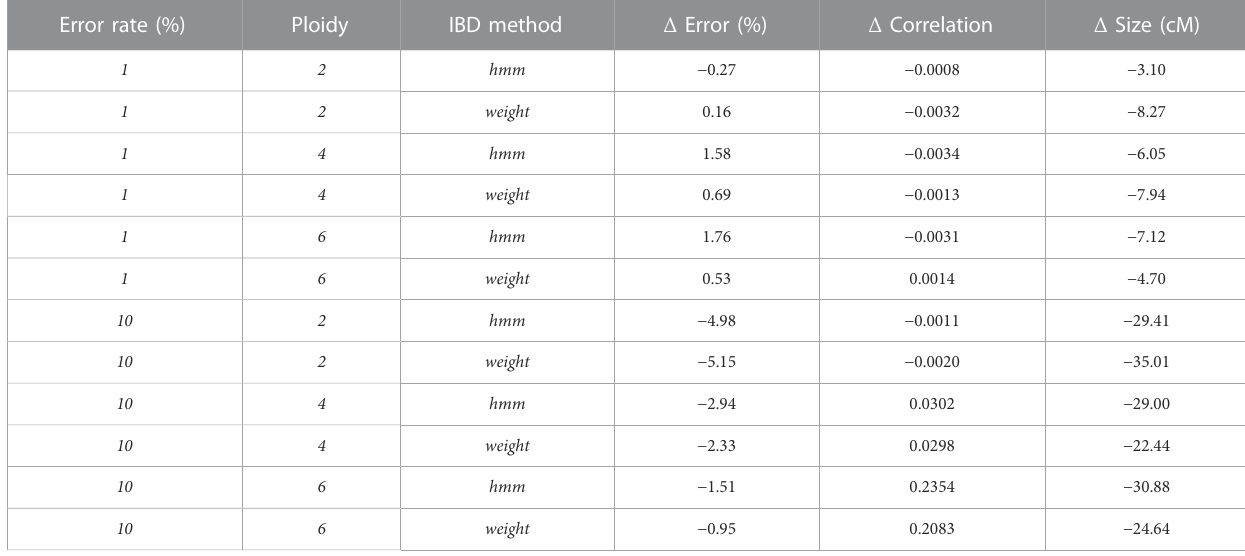
TABLE 1 Average change between preliminary map and last iteration of Smooth Descent. Error rate